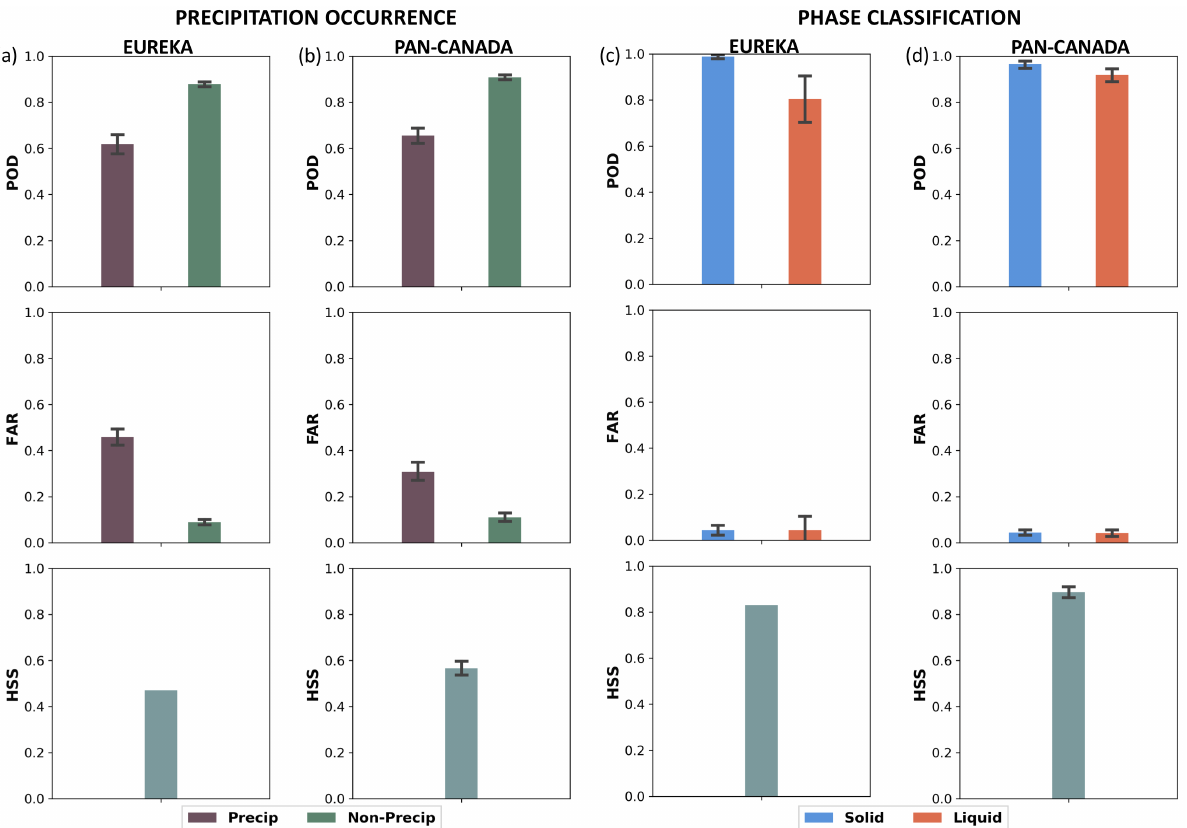
Figure 3. Estimates of POD (top), FAR (middle) and HSS (bottom) at Eureka ( a , c ) and pan-Canada ( b , d ) for precipitation occurrence ( a , b ) and phase classification ( c , d ). The error bars represent 95% confidence intervals on each estimate, assuming that the samples are